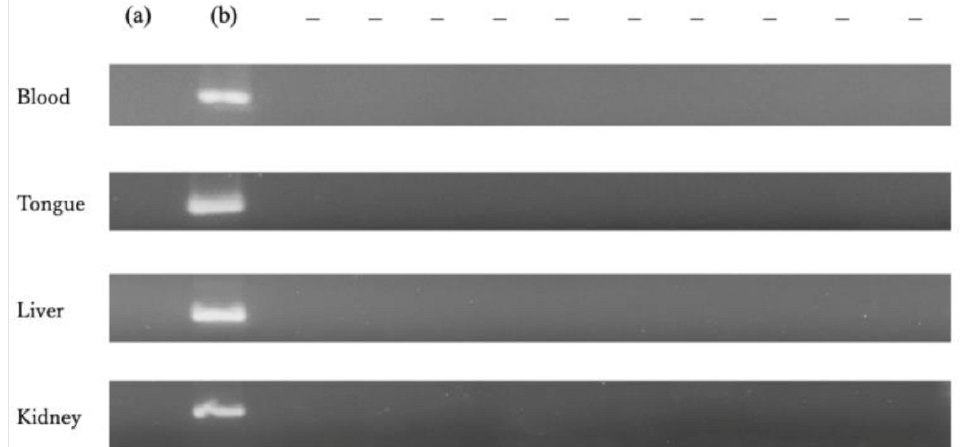
Figure 5. Results of nested PCR. Lane ( a ): negative control (buffer), lane ( b ): positive control ( C. albicans ); the lane to the right indicates positive (+) or negative ( − ). All specimens from the blood, the tongue, the liver, and the kidney were negative for C. albicans , indicating that there was no contamination of the experimental environment and experimental